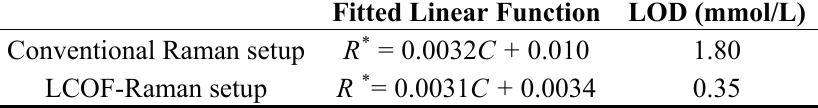
Table 3. The fitted linear functions and LODs of conventional Raman and LCOF-Raman experimental setup. (PPO Raman is employed as spectrometer, and the length of the LCOF is 50 cm.)